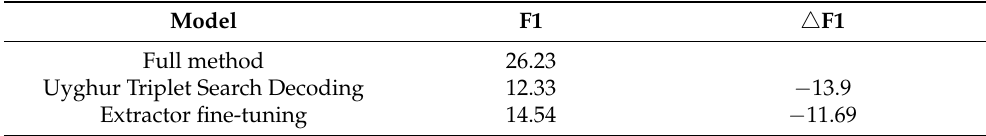
Table 8. Ablation results of Uyghur multi-triplet extraction.